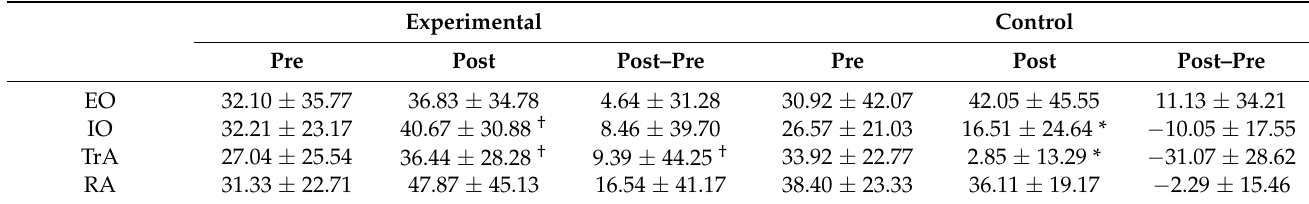
Table 2. Comparison of change rate of abdominal muscle thicknesses (unit: %).